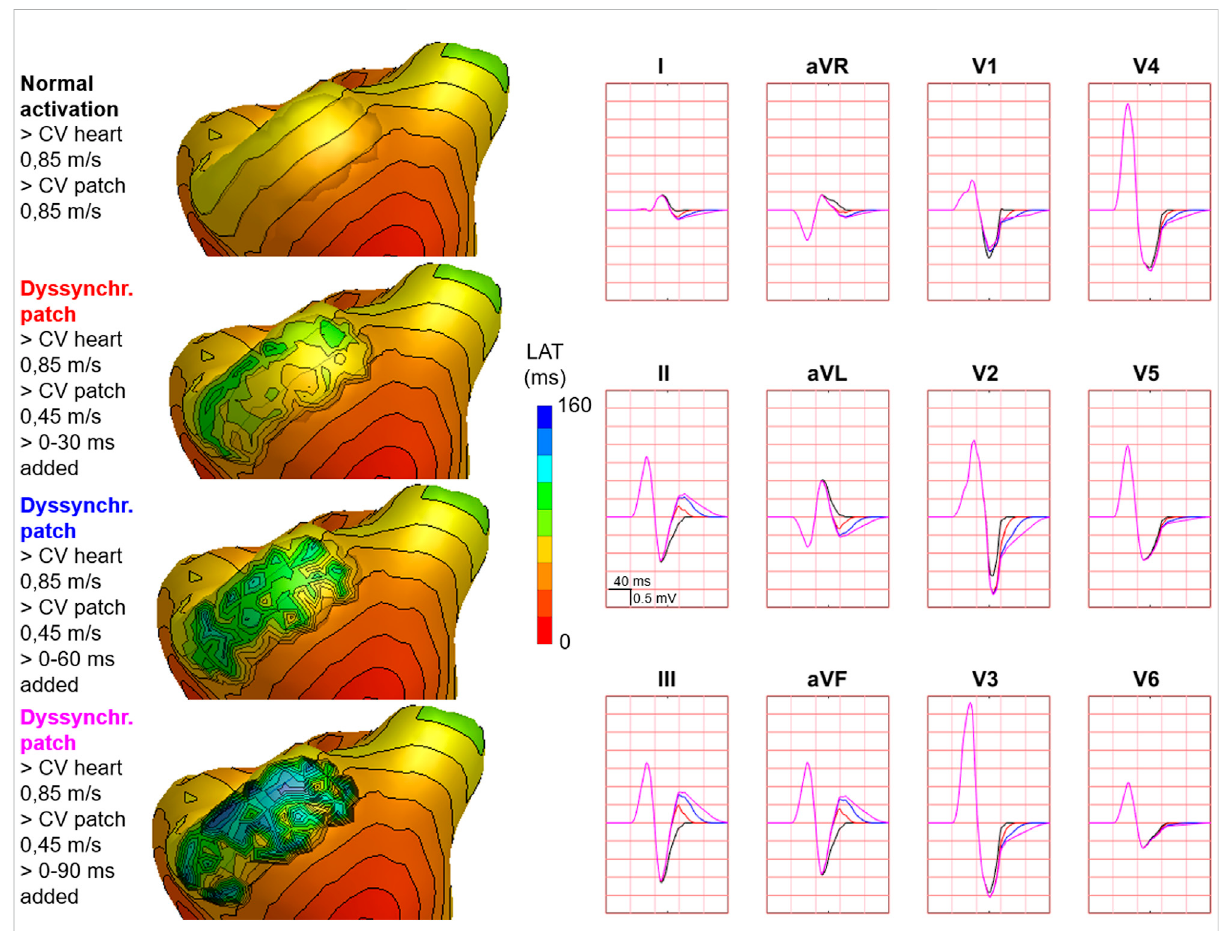
FIGURE 5 Effectofdyssynchronouspatchactivationonbodysurfacepotentials.Representativeexampleoftheeffectofdyssynchronouspatchactivation. Activation sequences of the patches and ventricles are displayed from red (early) to blue (late) with isochrone steps of 10 ms. Simulated BSP are displayed as 12-lead ECG. The colors in the ECG correspond to the colors stated in the left column with the simulation characteristics.